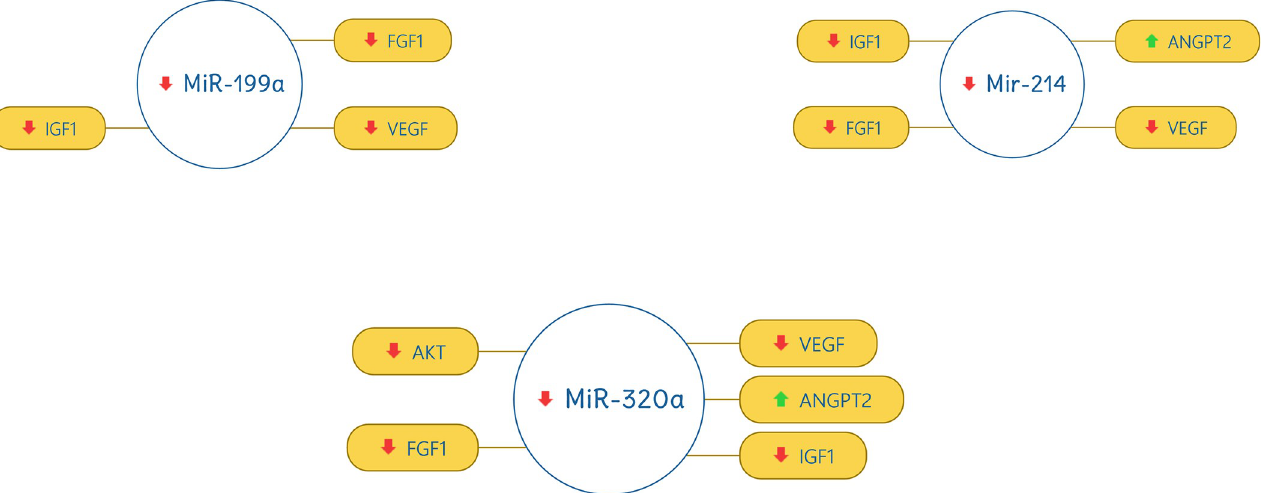
Fig 4. Correlation of miR-199a, miR-214, and miR-320a with selected genes. The red downward arrow shows the down-regulation of genes and the green upward arrow for the up-regulation of genes.